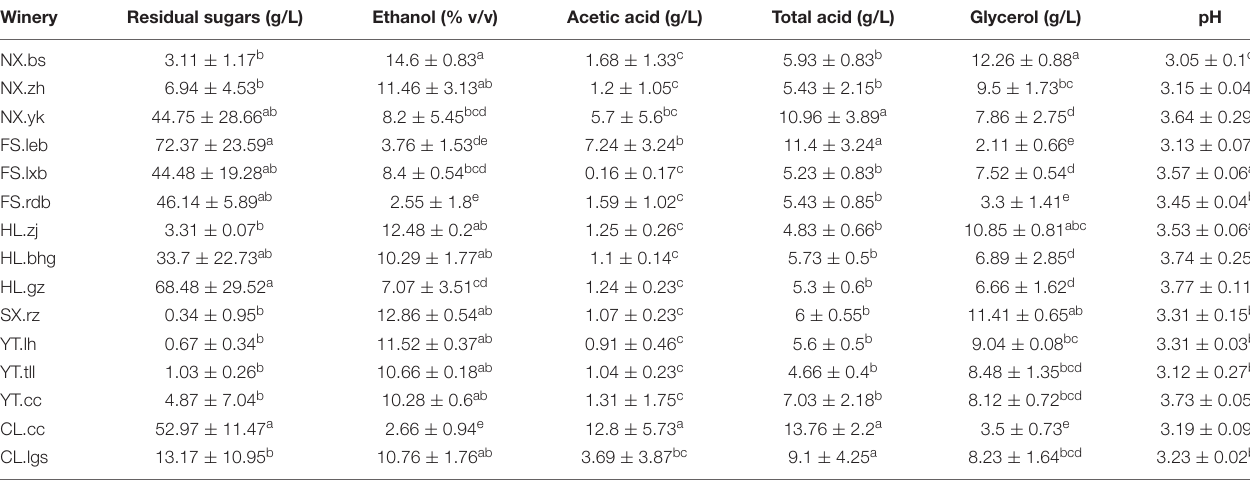
TABLE 3 | The physicochemical parameters of spontaneously fermented Marselan wine. Winery Residual sugars (g/L) Ethanol (% v/v) Acetic acid (g/L) Total acid (g/L) Glycerol